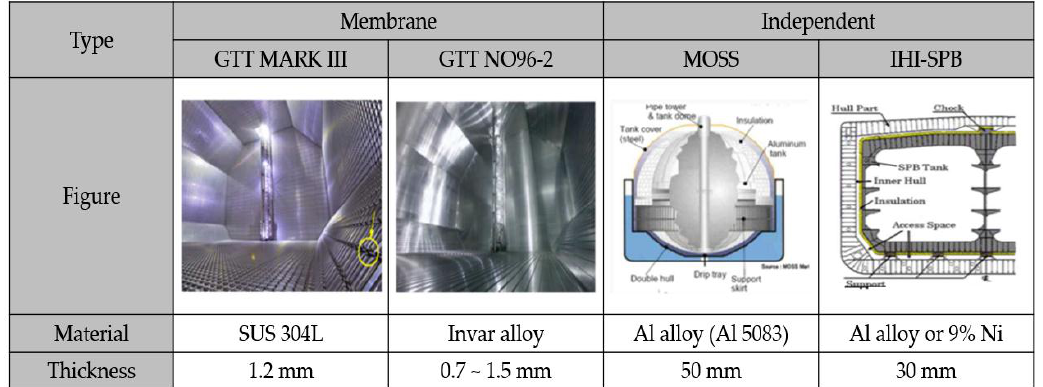
Figure 1. Detailed information of liquefied natural gas (LNG) storage tanks [4].